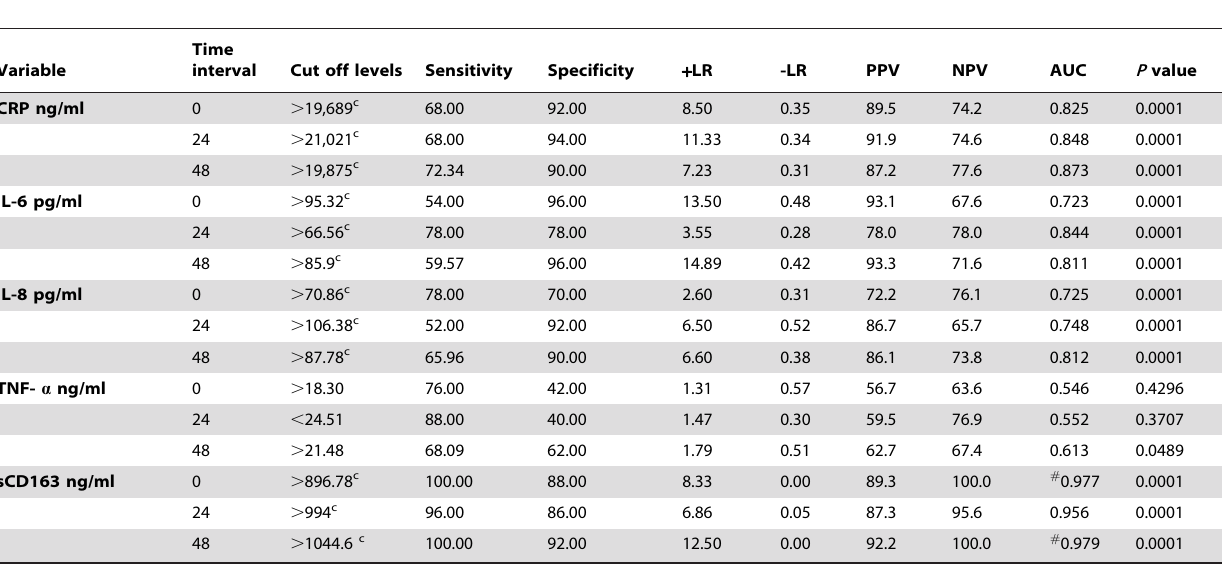
Table 5. Predictive ability of the study parameters to differentiate between the non-infected and infected neonates at different time intervals.